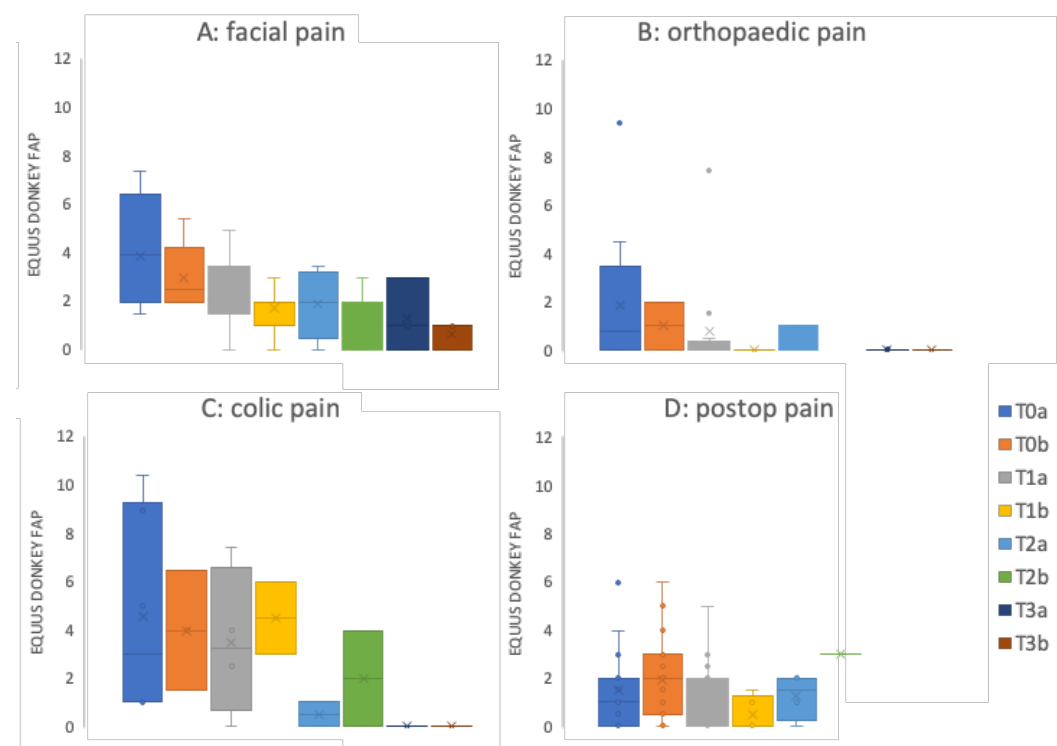
Figure 7. EQUUS-DONKEY-FAP mean patient scores over time. ( A) Facial pain ( n patients on Day 0: T0a